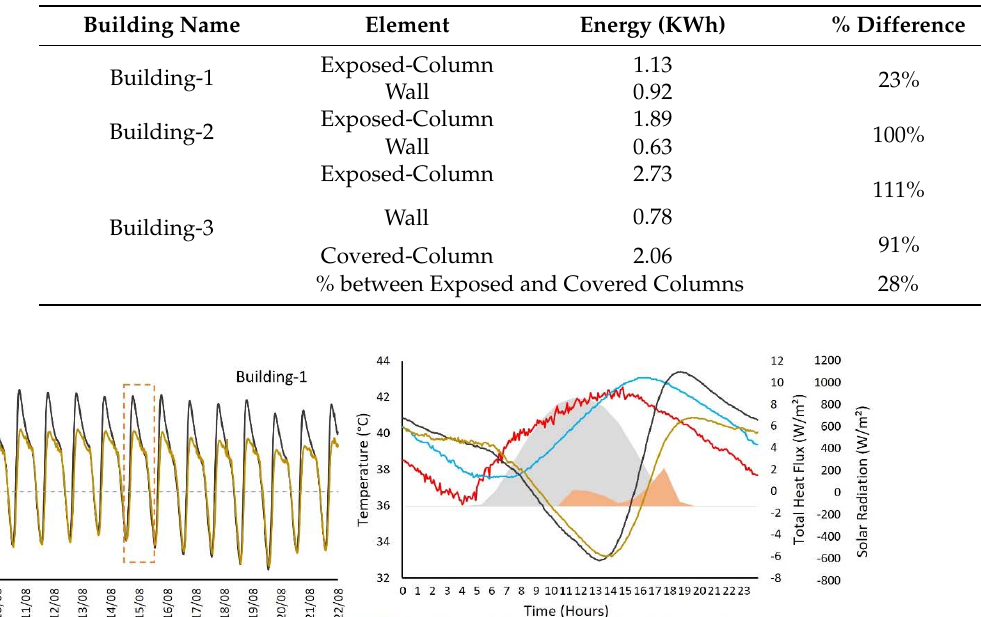
Table 3. Total energy transmittance entering the building through structural elements and wall with the % differences between the two